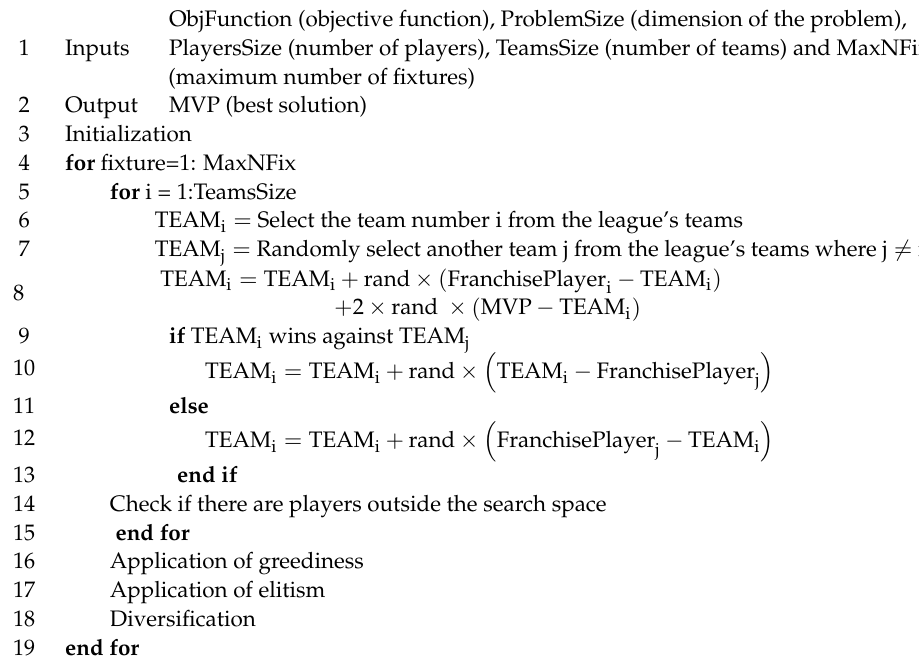
Algorithm 1. MVPA